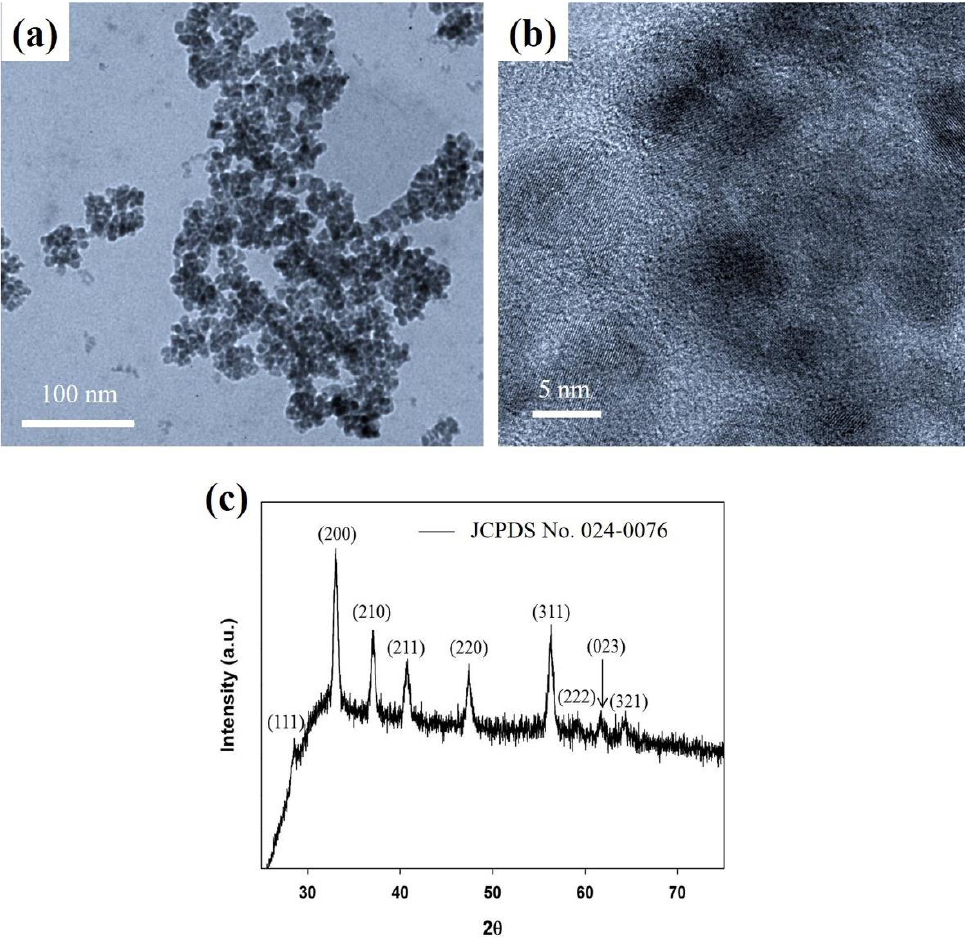
Figure 2. ( a ) Transmission electron microscopy (TEM), ( b ) high-resolution TEM (HR-TEM) images of iron pyrite nanocrystals, and ( c ) X-ray diffraction pattern of iron pyrite nanocrystal with the reference peak positions of cubic phase. The topography and three-dimensional (3D) images of the surface roughness of the ITO/PEDOT: PSS (or GO)/ FeS 2 + PBT7 without PEDOT: PSS and GO are displayed in Figure 3a – f. With PEDOT: PSS, the (FeS 2 + PBT7) film had a roughness of 6.66 nm, which was smaller than that without the PEDOT:PSS film (~8.43 nm), as shown in Figure 3a,b. The roughness of the FeS 2 + PBT7 film with a different spin speed (SS) of the GO (SS 1000, SS 2000, and SS 3000) were also investigated, as shown in Figure 3c–f. With GO (SS 2000) (as Figure 3d), the (FeS 2 + PBT7) film had the smallest roughness of 3.54 nm. The result depicts that by using PEDOT: PSS and GO as the hole transporting buffer layer, the surface roughness of the photoactive layers was improved.